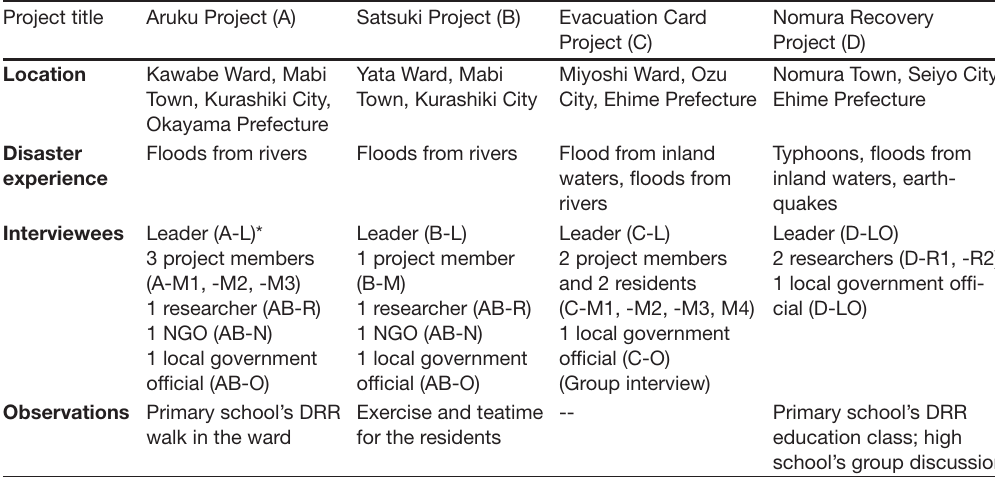
Table 4. Details of the four case